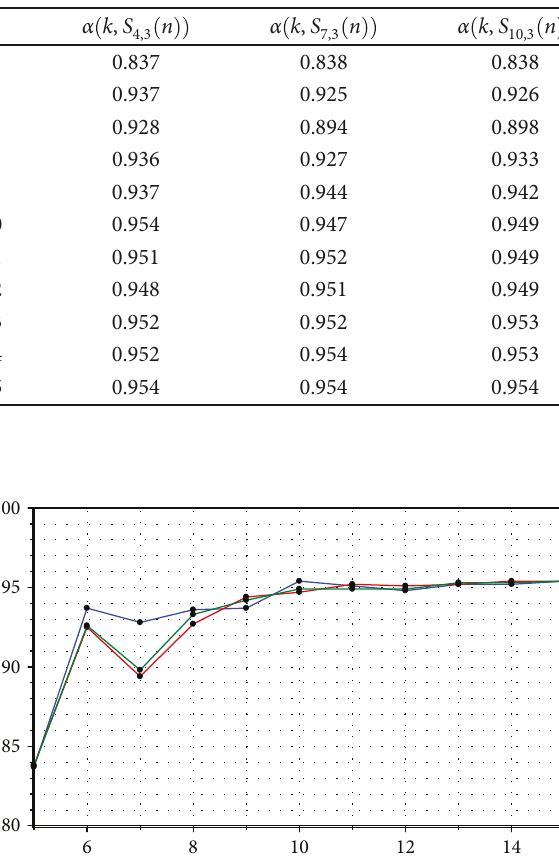
n . Green: α k , S 7,3